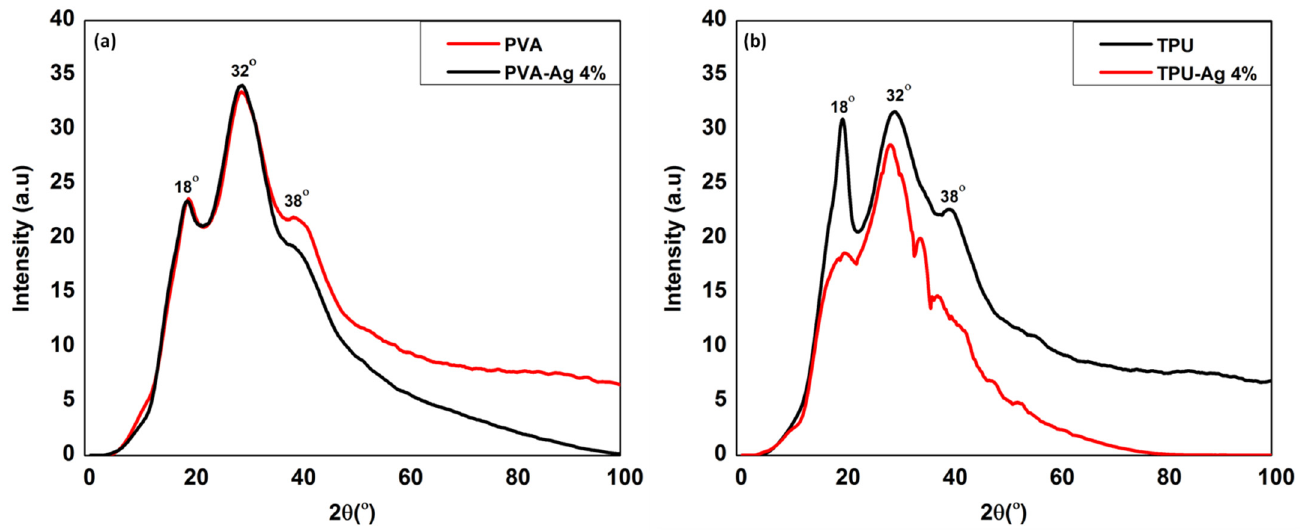
Figure 3. XRD of ( a ) PVA, PVA-Ag 4% and ( b ) TPU, TPU-Ag 4%